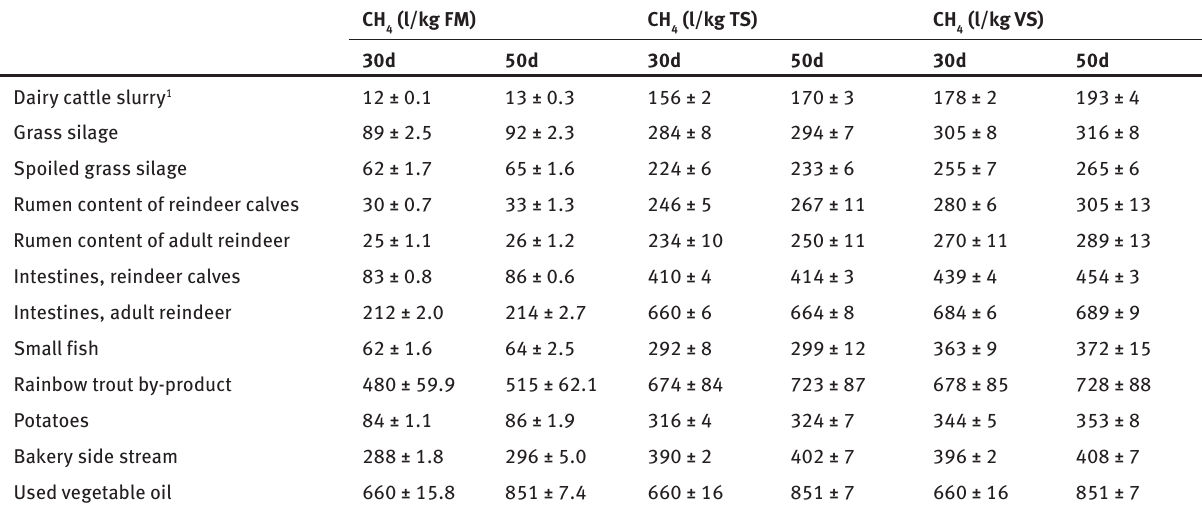
Table 4 : The BMP of the tested